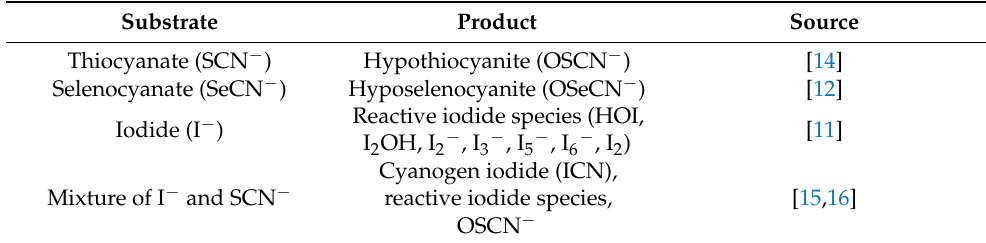
Table 1. Substrates and products of the lactoperoxidase (pseudo)halogenation cycle that are the subject of the present